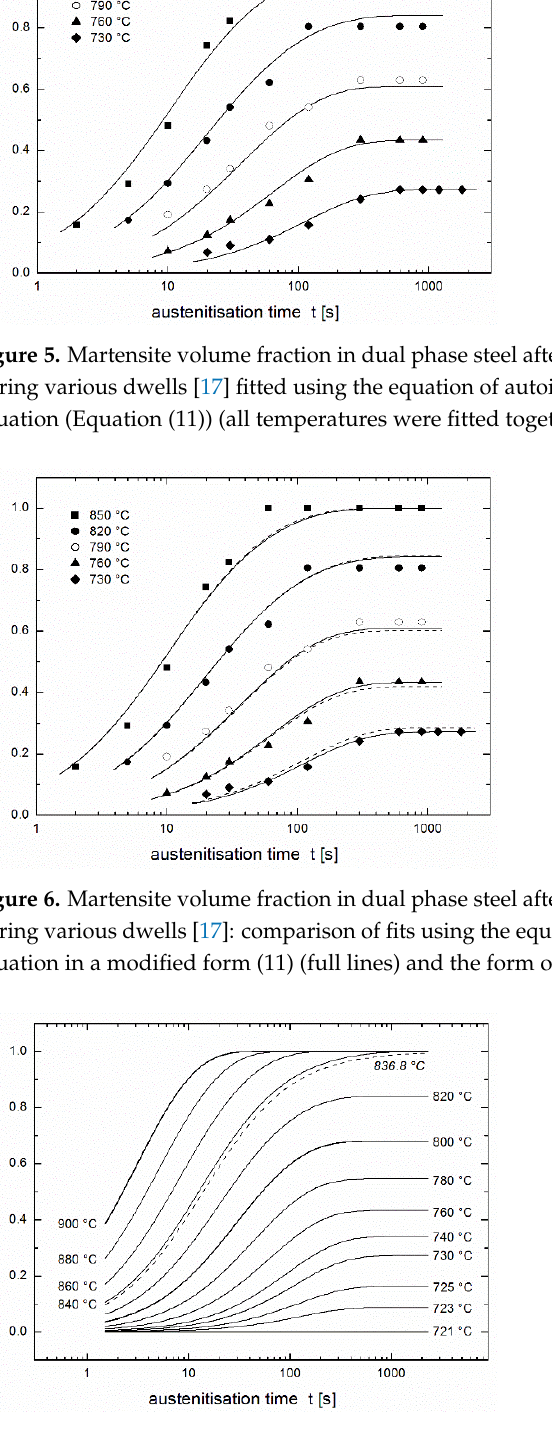
Figure 7. Family of predictive curves for the given temperatures. Prediction is based on the regression using the equation of autoinhibition (3) and the modified Arrhenius equation (11), see Figure 5.